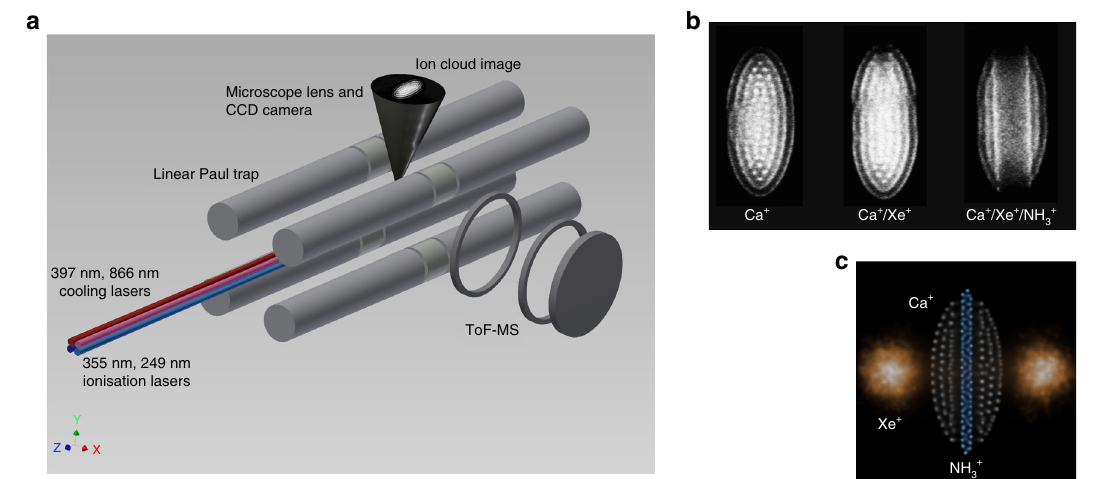
Fig. 1 Experimental set-up. a Coulomb crystals are formed when trapped Ca þ ions are laser cooled. The lattice positions of the constantly fl uorescing Ca þ ions can be directly observed by a charge-coupled device (CCD) camera, with the presence of other co-trapped species inferred from changes to the Ca þ fl uorescence pattern. Time-of- fl ight (ToF) traces are recorded by ejecting the ions from the trap and onto a multichannel plate (MCP) detector. See the “ Methods ” section for further details. b Experimental images of mono-component ( Ca þ -only, left), bi-component ( Ca þ and Xe þ , centre) and tri-component , right) Coulomb crystals, showing the progress of the charge exchange reaction. c False-colour image of a simulated tri-component ( Ca þ , Xe þ , and NH þ 3